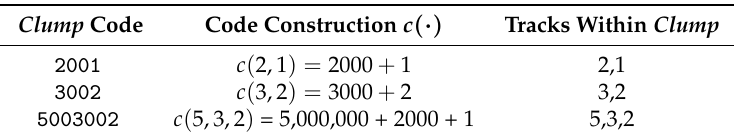
Table 2. Examples of clump codes created through the track labels obtained by PhagoSight by applying the defined codes. See text for detailed